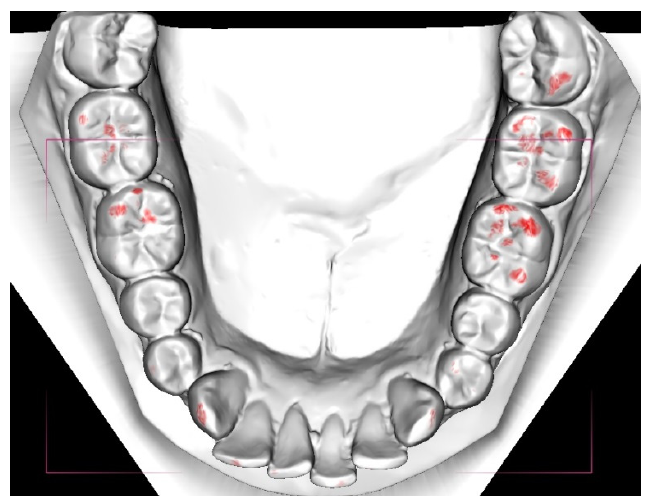
Figure 3. Lower jaw in the digital examination. Each cast was scanned four times, which resulted in four digital values for each cast. The mean of the four digital values for each scan was used in the comparisons of the